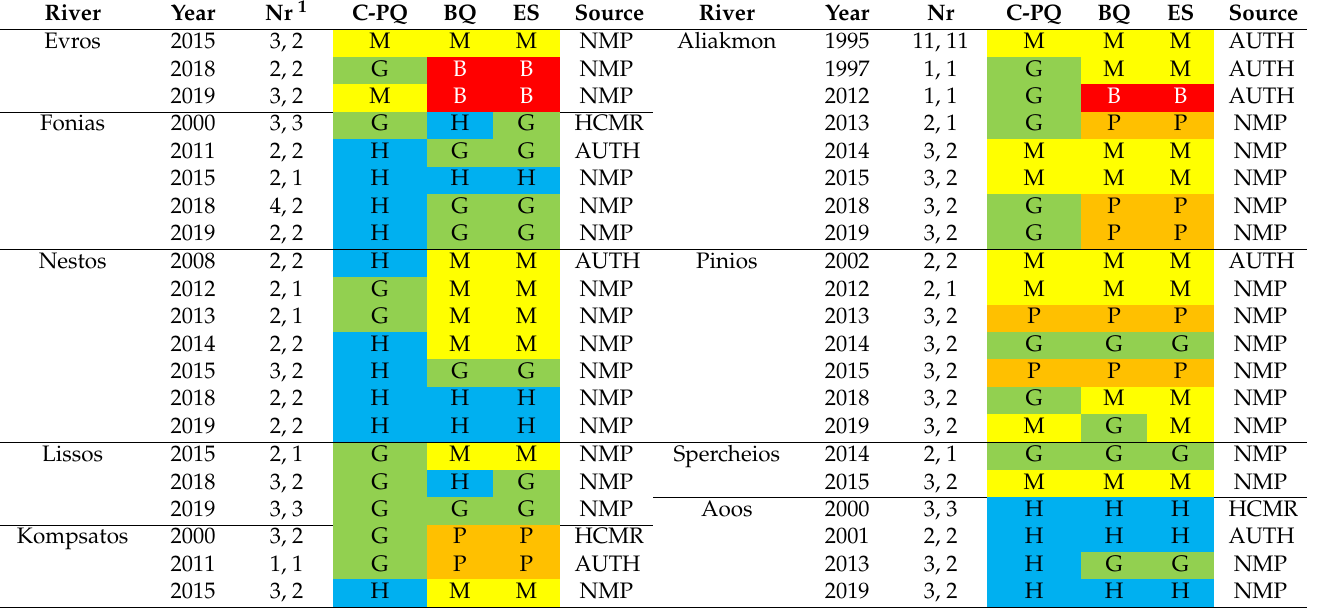
Table 3. Inter-annual variability of riverine ES near the river outflows using C-P variables and macroinvertebrates. Data according to the NMP, Aristotle University of Thessaloniki (AUTH), and the Hellenic Centre for Marine Research (HCMR). C-PQ, chemical—physicochemical quality; BQ, biological quality. H: high, G: good, M: moderate, P: poor, B: bad. Colors of ES correspond to the WFD